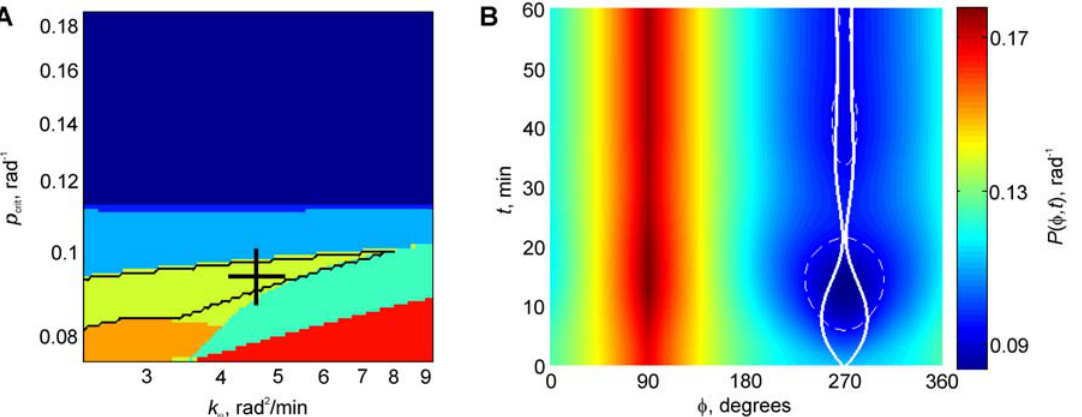
Figure 3. Model behavior when the TCR recycling point is opposite the APC contact initiation point. ( A ) Domains of the parameter space that determine qualitatively different dynamic scenarios. Color coding is the same as in Fig. 2a, with two additional regimes possible in the present case: medium-blue (a thin boundary domain separating the light- and dark-blue ones), in which the contact collapses completely without exceeding 30 u arc, and turquoise , in which the contact collapses completely after exceeding 30 u arc transiently. The domain outlined in black is determined as an intersection of the domains in this figure and in Fig. 2a: inside the black outline, the formation of a significant ( . 30 u ) contact is predicted to be stable if the point of the initial contact coincides with the point of recycling, and transient if the two points are diametrically opposed. Thus, inside the black boundary, the model reproduces our previous experiments. Cross denotes the parameter combination for the dynamic example shown in panel B , which is the same parameter combination as for the example in Fig. 2b. ( B ) Dynamics of the surface TCR distribution and contact boundaries. The plotting conventions are the same as in Fig. 2b. Recycling is directed to w =90 u (the top of the cell in the experiments), and the contact is initiated at w =270 u (cell bottom).